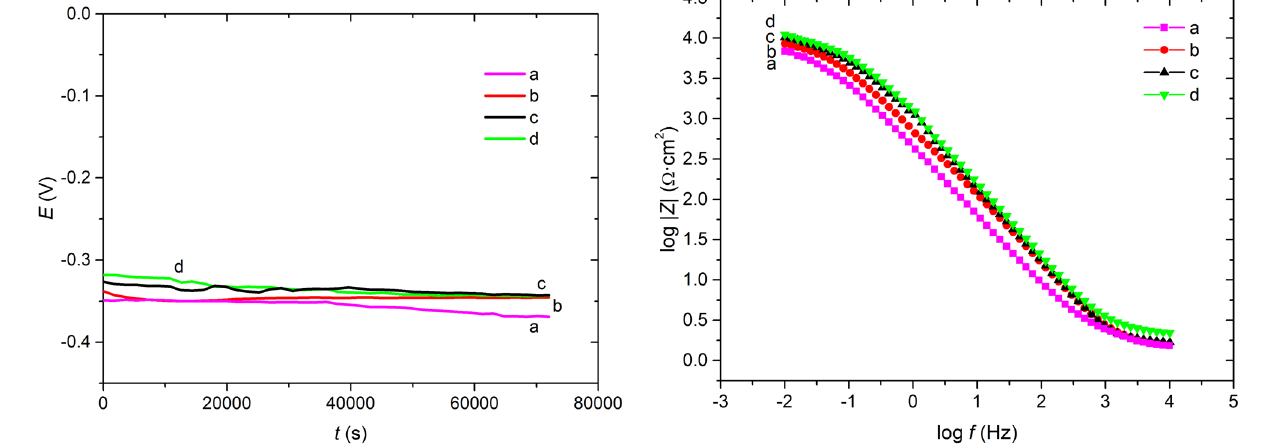
Figure 6: Dependences of log ǀ Z ǀ = f ( log f ) for the coatings: Ni – 18.7Re ( a ) , Ni – 32.7Re ( b ) , Ni – 35.3Re ( c ) , and Ni – 37Re ( d )